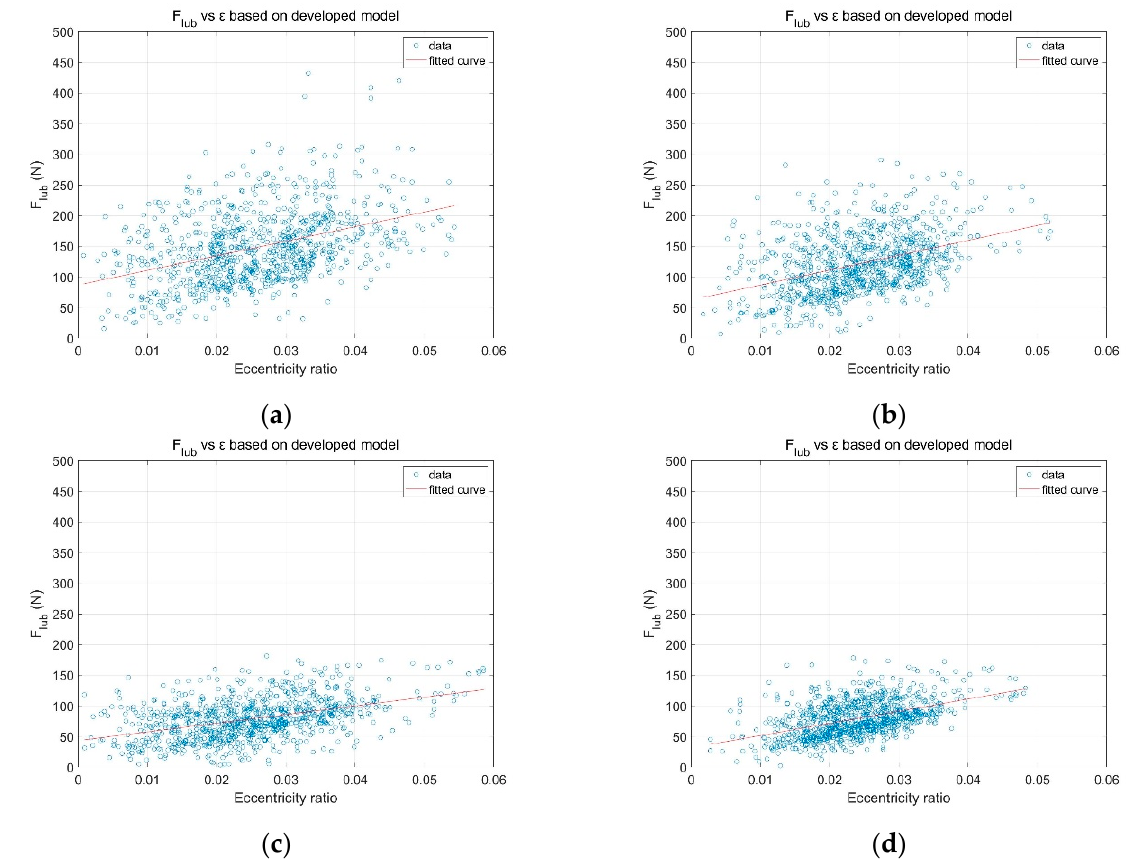
, as shown in Figure 22. The (cid:3013)(cid:3022)(cid:3003) . However, (cid:3013)(cid:3022)(cid:3003) . It seems that the (cid:3013)(cid:3022)(cid:3003) . (cid:3013)(cid:3022)(cid:3003)